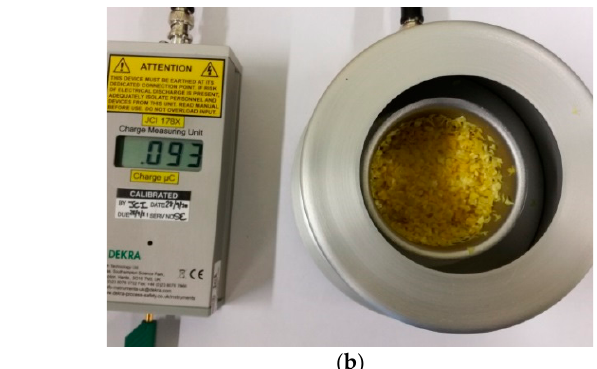
Figure 7. ( a ) Dimensions of the container for circulation of the tested mixed polymers and ( b ) movement of polymer particles during the tribocharging process.